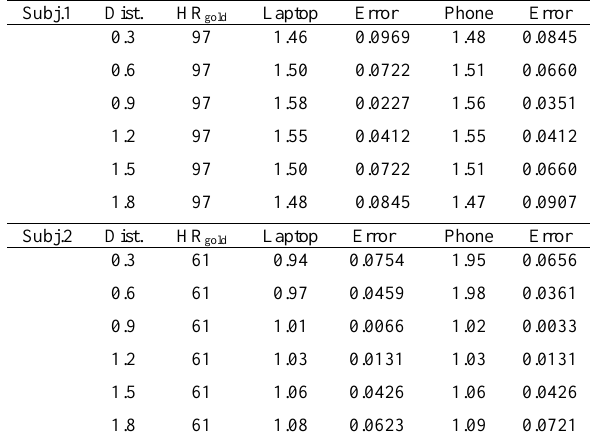
Fig 4. Comparison of measurements obtained from the both kinds of cameras for all the ten subjects. (a,c) Bland-Altman plots. (b,d) Scatter plots Table 2. Distance vs. accuracy for two of the